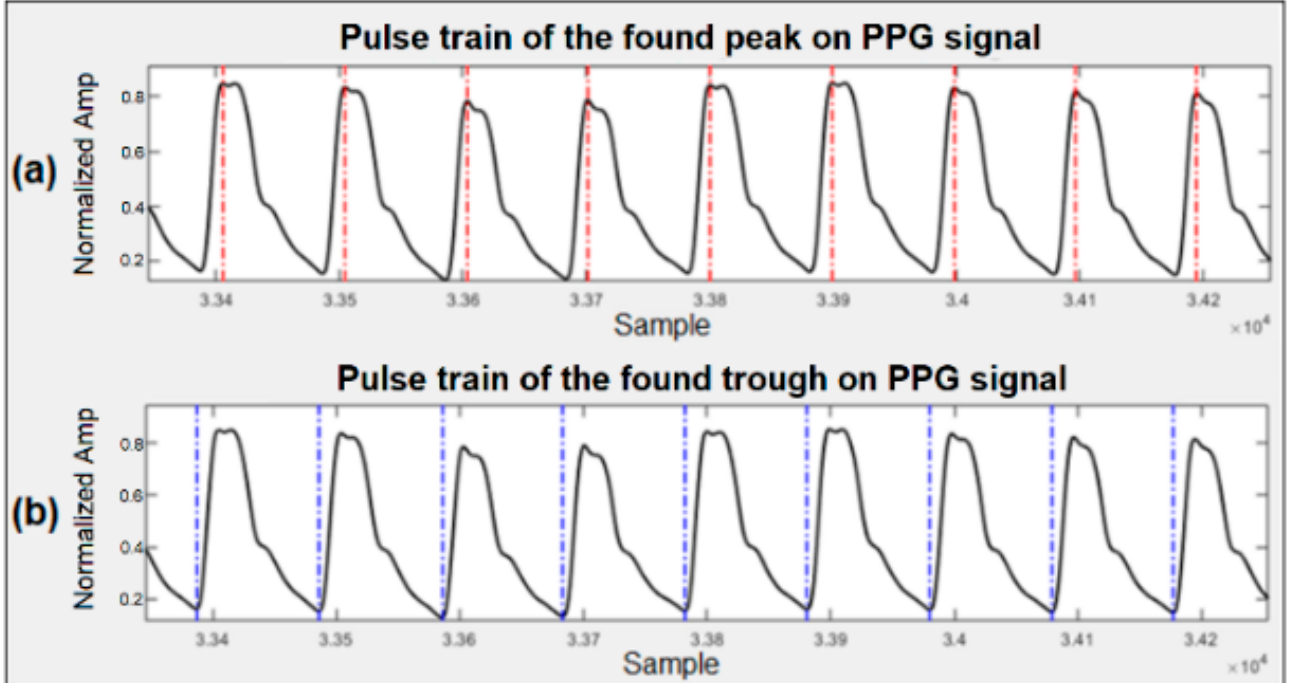
Figure 3. Detection of peaks and troughs in the PPG signal. ( a ) Detected peaks marked with dotted red lines. ( b ) Detected troughs marked with dotted blue lines.